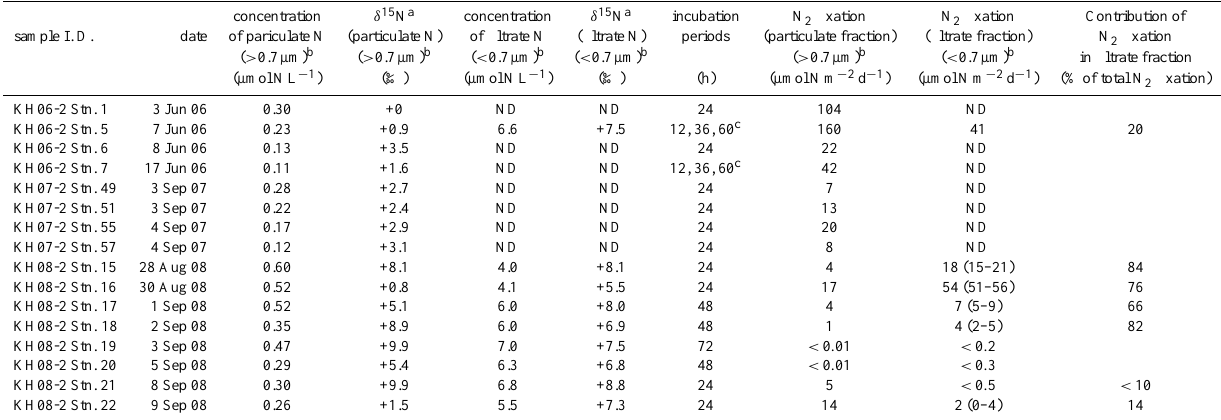
Table 2. Areal N 2 fixation rates for each fraction and initial δ 15 N values concentration δ 15 N a concentration δ 15 N a incubation N 2 fixation N 2 fixation Contribution of sample I. D. (particulate fraction) (filtrate